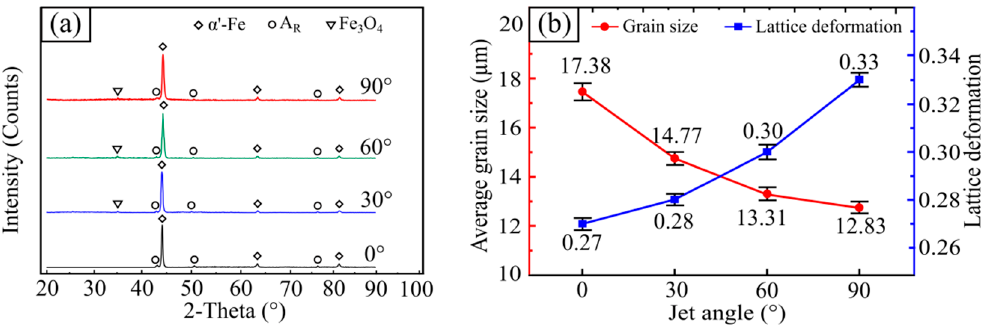
Figure 6. ( a ) The X-ray diffraction pattern characteristics on the tested sample surface; ( b ) the average grain size and lattice deformation at different jet angles.